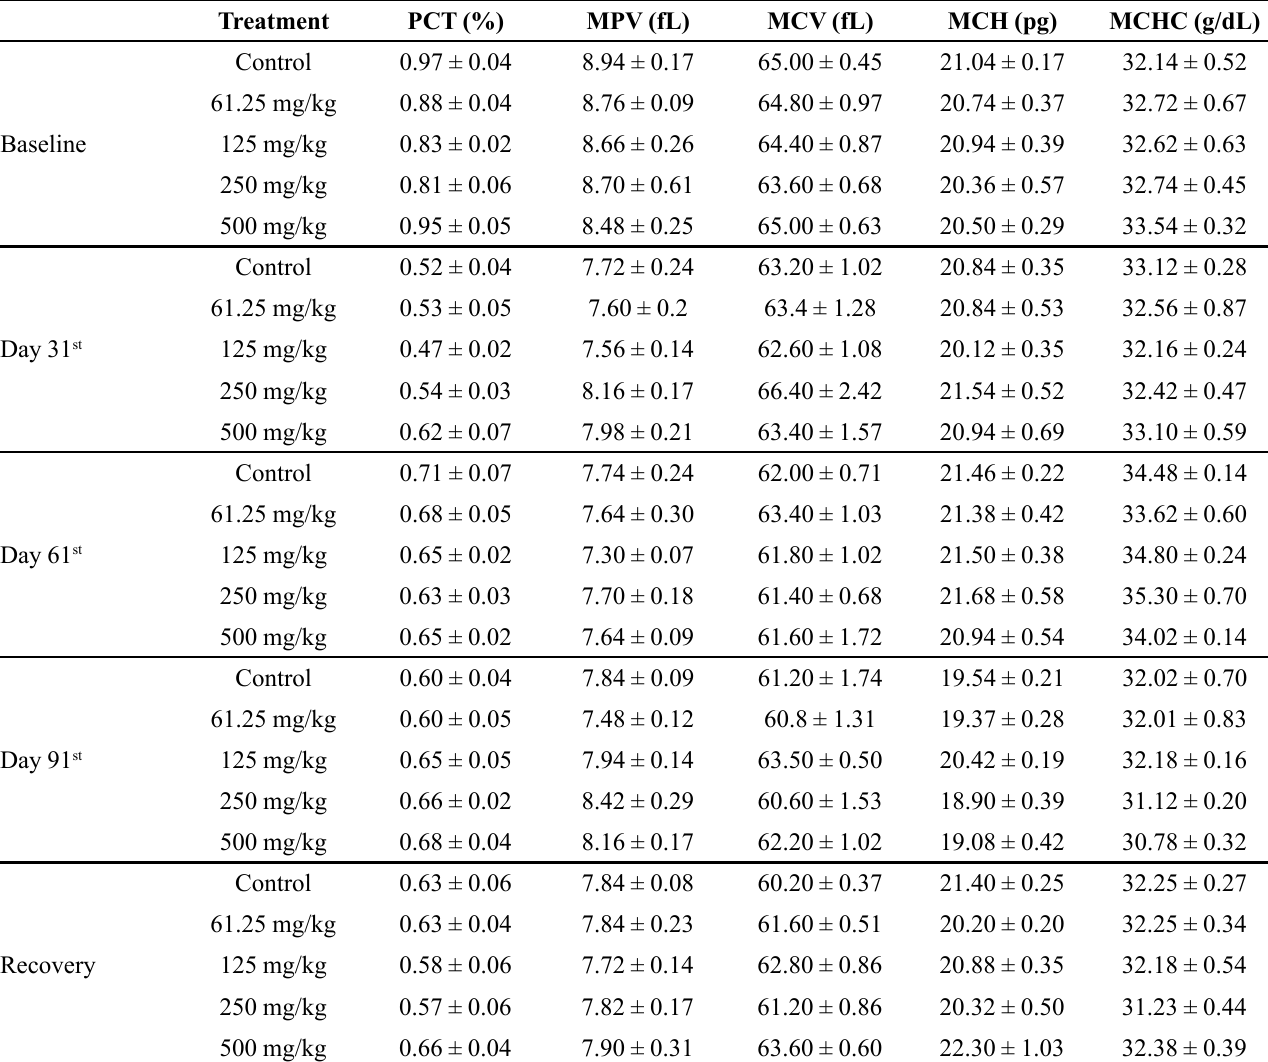
TABLE IV - Effect of sub-chronic administration of Dryopteris filix-mas ethanol leaf extract on platelet percentage (PCT),